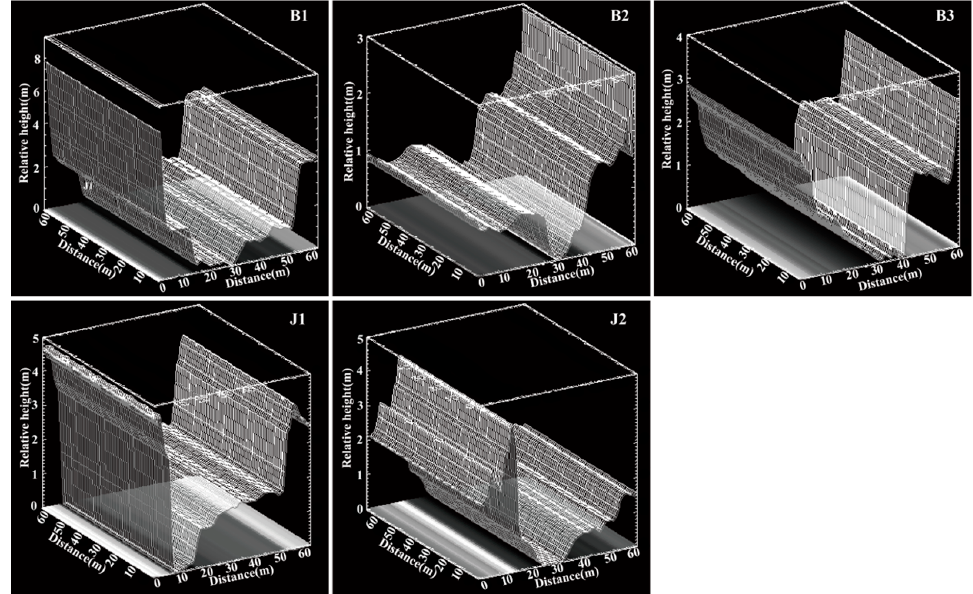
Figure 3. Digital model of river section. B1~B3 are the cross-sectional morphology of the Bortala River; J1~J2 are the cross-sectional morphology of Jing River. River; J1~J2 are the cross-sectional morphology of Jing River.